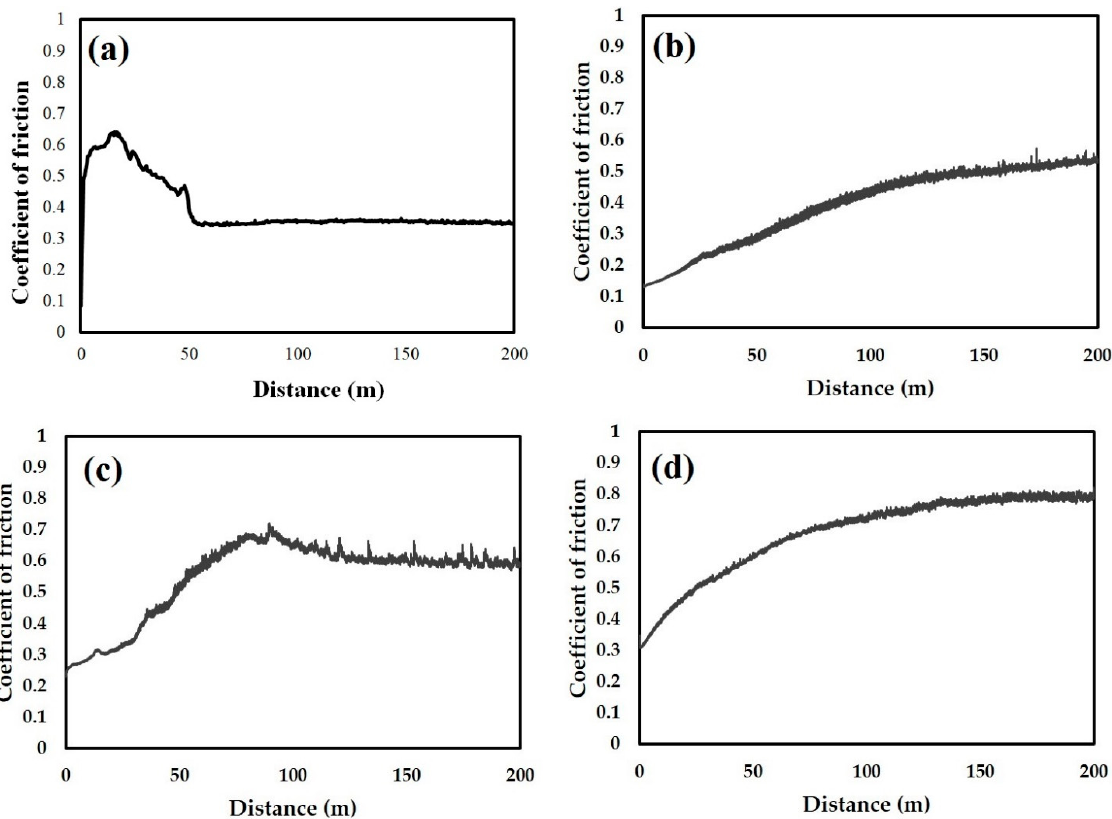
Figure 7. CoF evaluated by a pin-on-disk test applied to sample ( a ) untreated and ( b – d ) exposed to carburizing, nitriding, and boriding hardening processes, respectively.